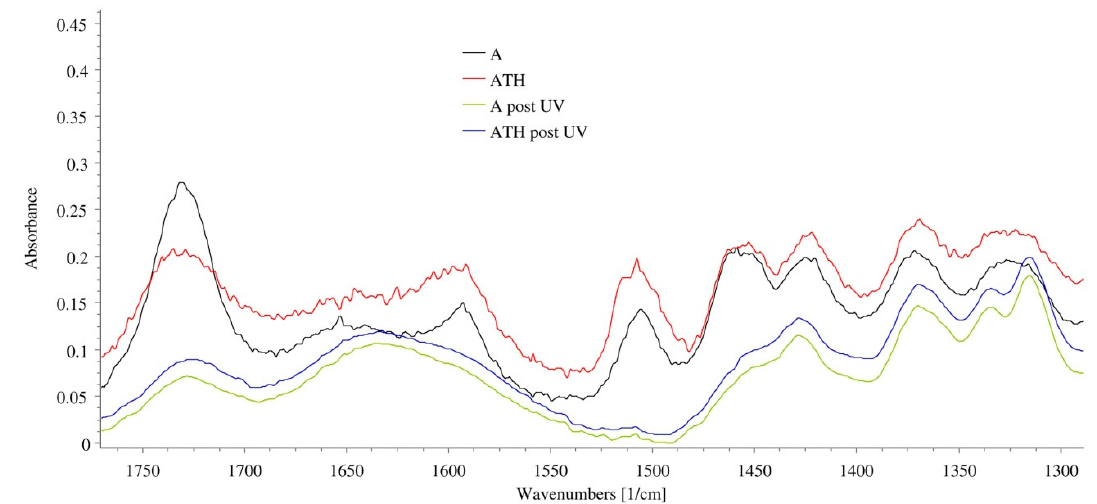
Figure 4. Comparison of FTIR spectra of A and ATH before and after UV of the fingerprint region.